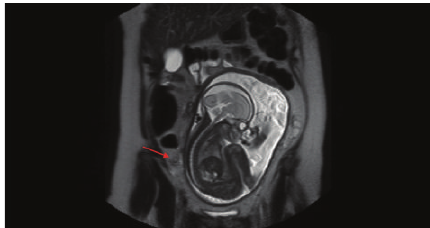
Figure1:MRIT2coronalview:freefluidandinflammatorychanges around the appendix (arrow). Gravid uterus.